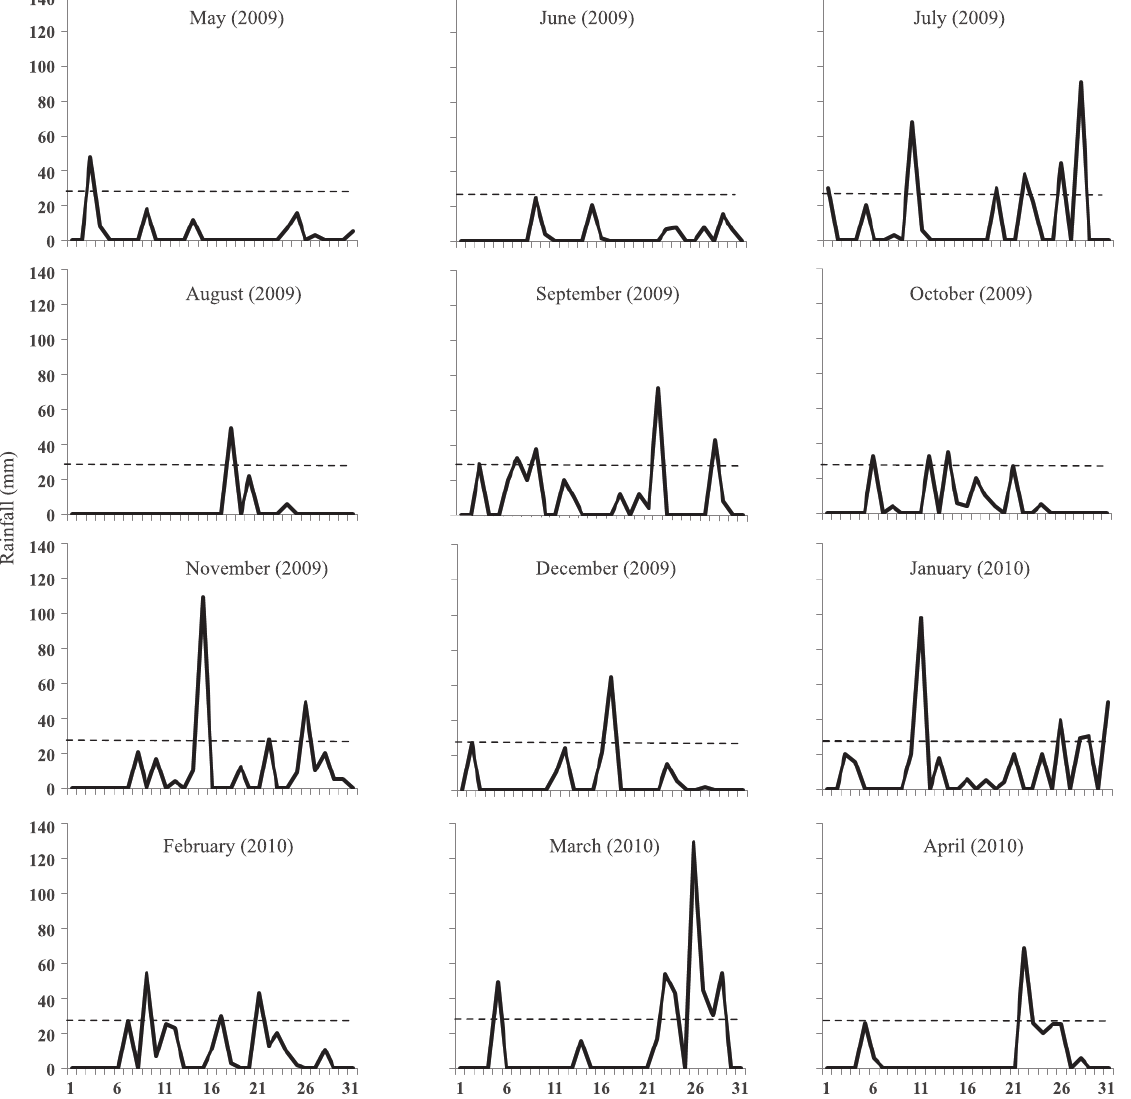
figure 4. daily rainfall during the experimental period. peaks above the dotted line indicate the presence of wetting and drying cycles in the